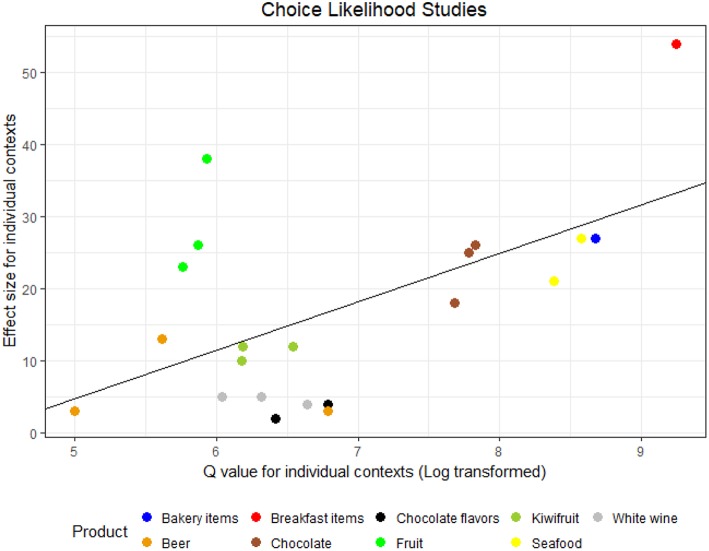
Size of the difference in appropriateness (Cochran's Q) plotted against effect size (R2) for studies 1–5 and 6a–10a, with superimposed line of best fit (y = −28.7 + 6.7x, R2 = 33%, p = 0.006).